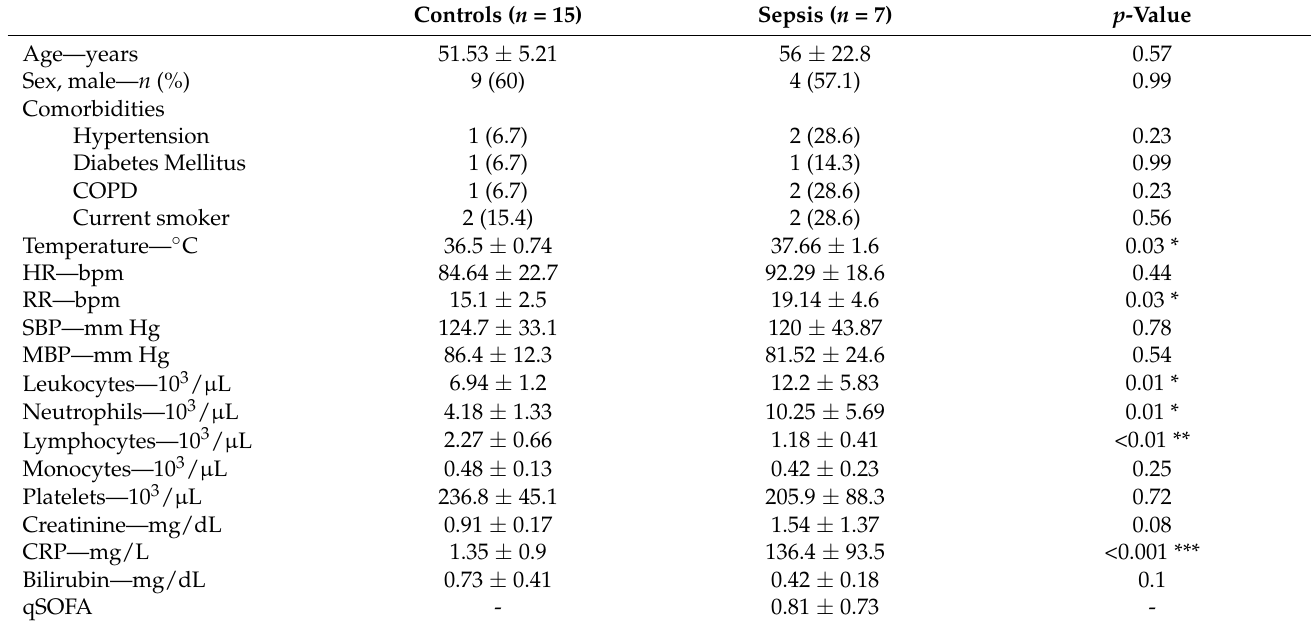
Table 1. Baseline characteristics of sepsis patients and healthy controls at hospital admission. Controls ( n = 15) Sepsis ( n = 7) p